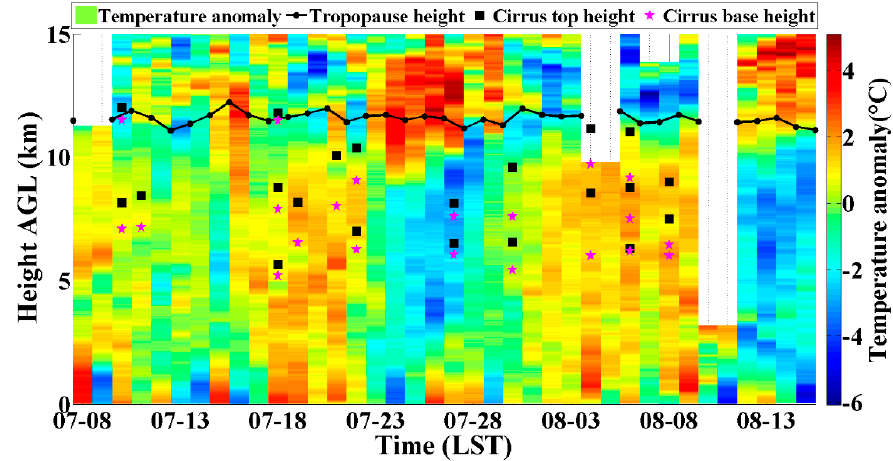
Figure 8. Temperature anomalies during July and August 2014.